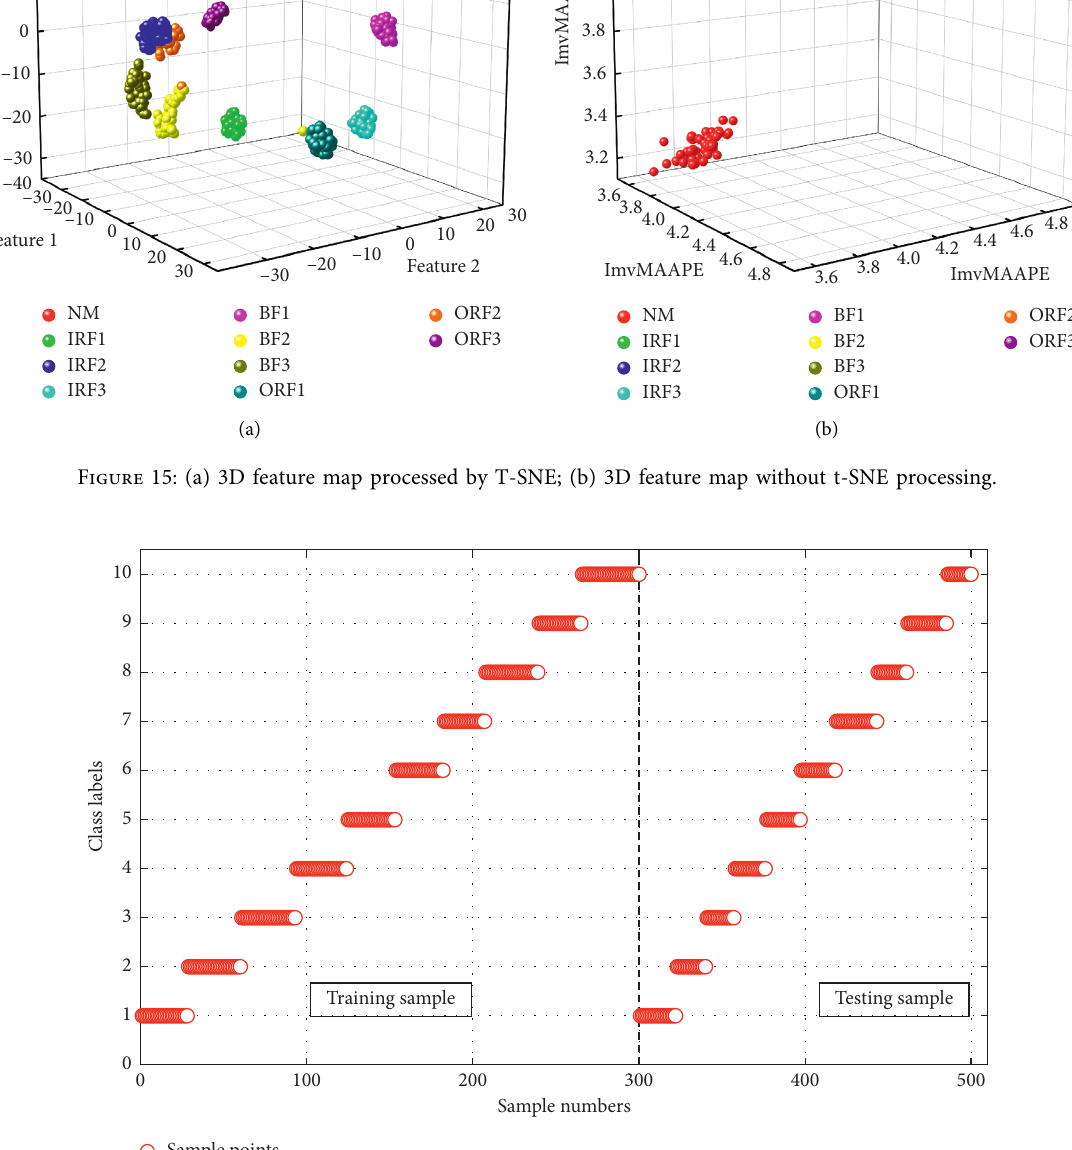
Figure 16: The identification and classification results of the bearing faults using the method proposed in this paper. Table 4: The fault detection results of 20 experiments using the method proposed in this paper. The proposed